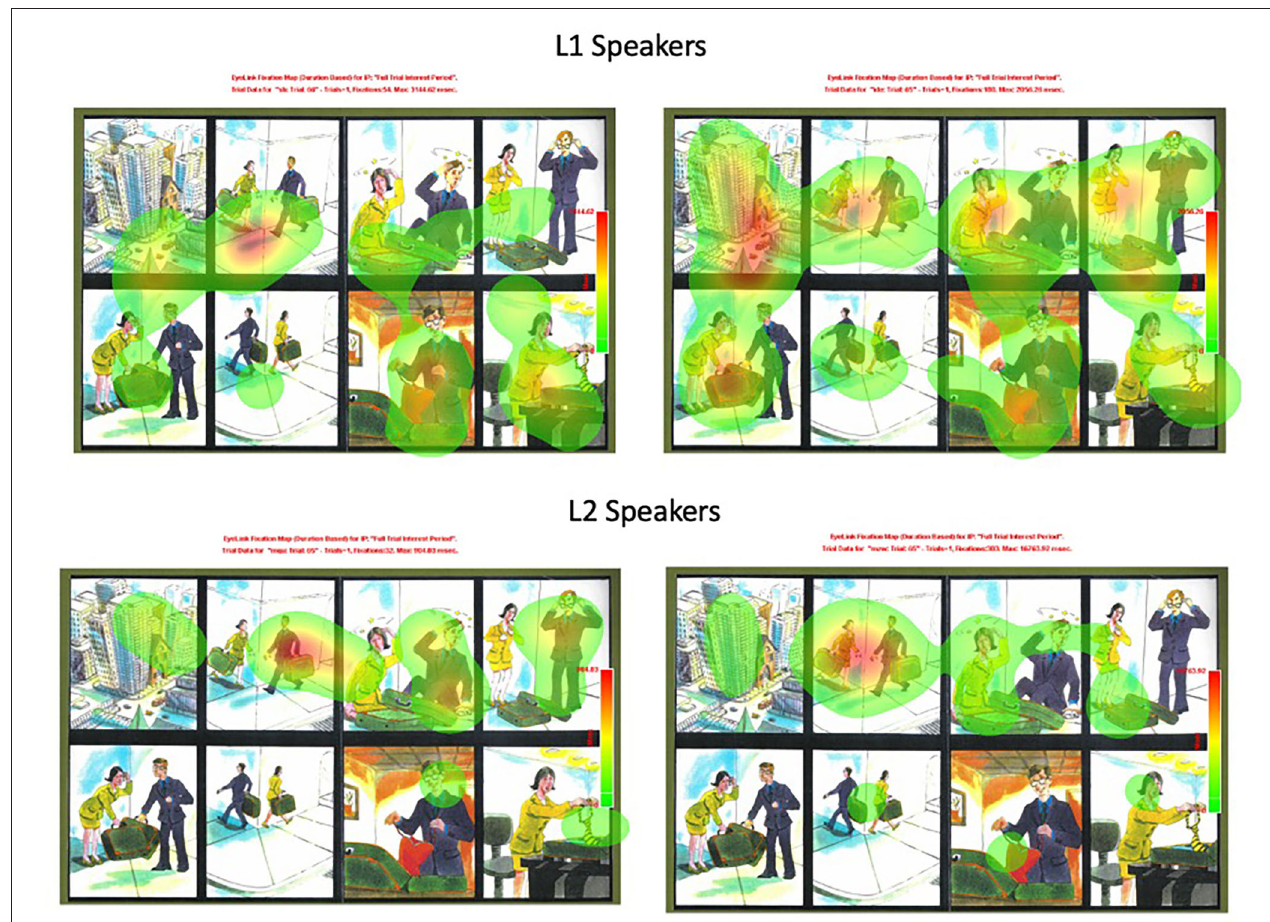
FIGURE 4 | L1 English and Mandarin-English L2 speakers’ processing of pictorial